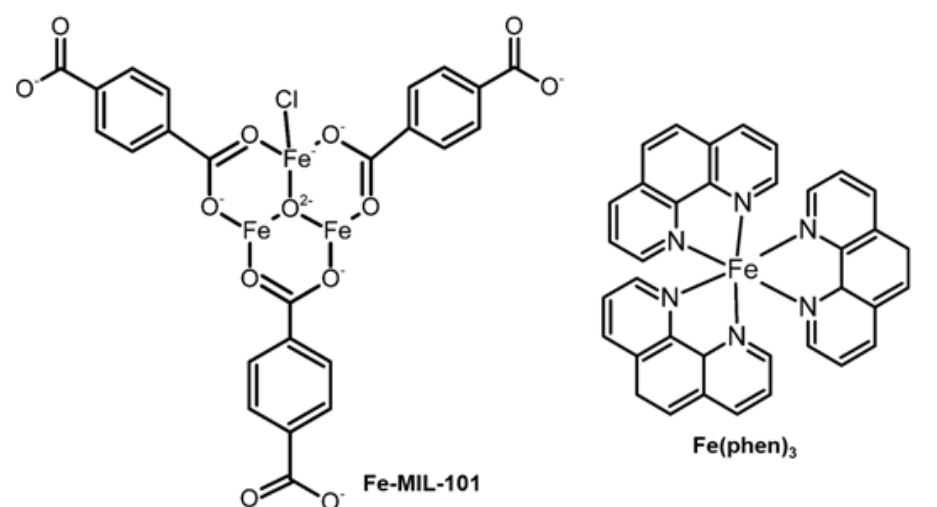
Figure 8. Fe complexes regulating the activity and expression of MMPs.